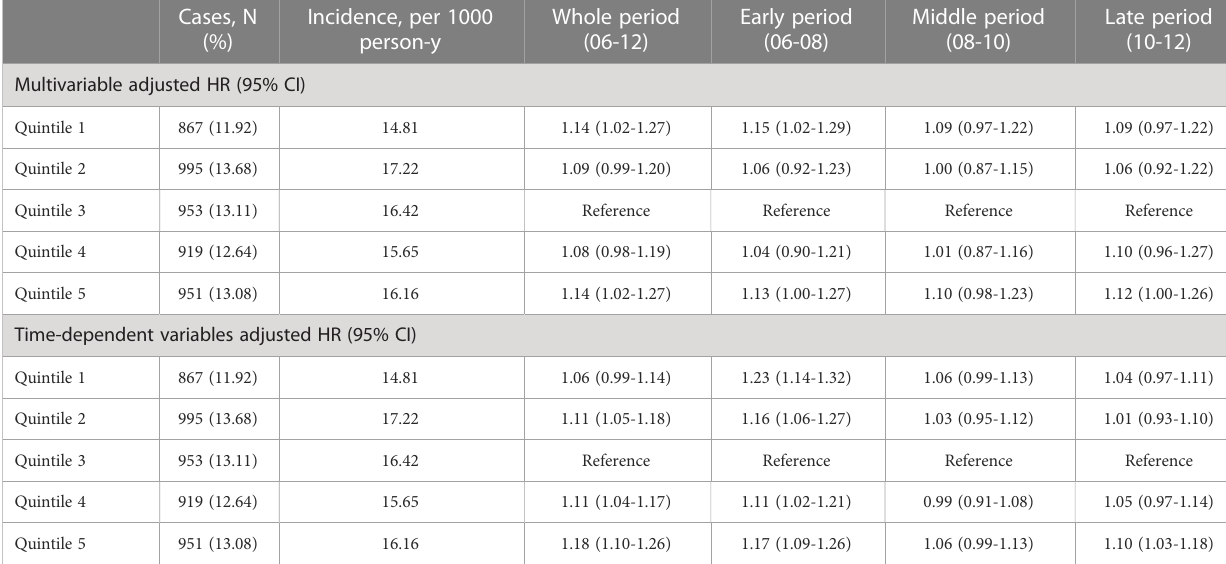
TABLE 4 Hazard ratios (95% CI) for risk of outcomes according to quintiles of TyG index